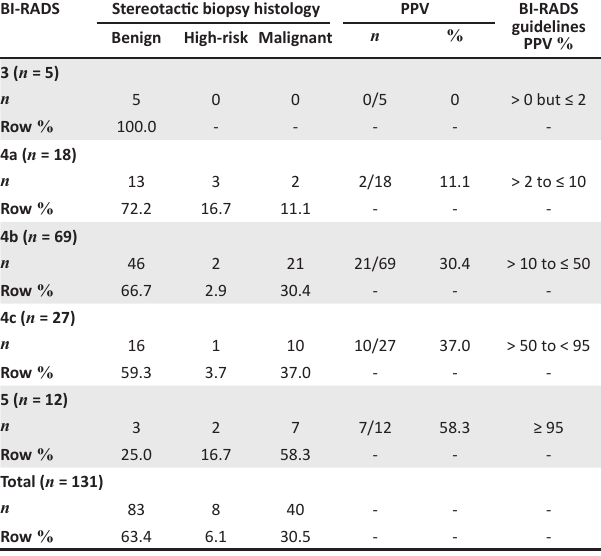
TABLE 2: Distribution of histological diagnosis as per breast imaging reporting and data system category. BI-RADS Stereotactic biopsy histology PPV BI-RADS